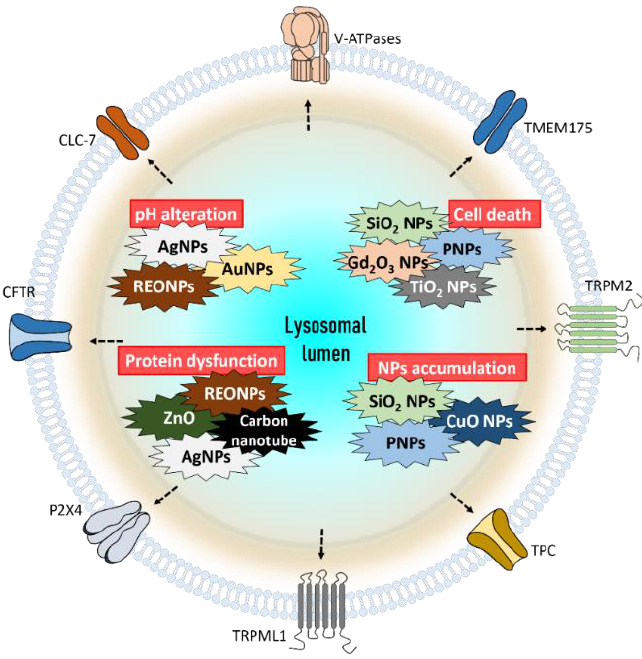
Figure 4. The summarized role of nanoparticles which effect lysosomes and cellular functions. Exposure to AgNPs, AuNPs, and REONPs induces alkalization of lysosomal lumen. SiO 2 NPs, Gd 2 O 3 NPs, PNPs, and TiO 2 NPs damage lysosomes, which finally trigger cell death. The lysosomal protein can be damaged by ZnO, REONPs, AgNPs, and carbon nanotubes. Accumulation of SiO2 NPs, PNPs, and CuO NPs can induce lysosomal dysfunction. Abbreviations: REONP: rare earth oxide nanoparticle; PNP: polystyrene